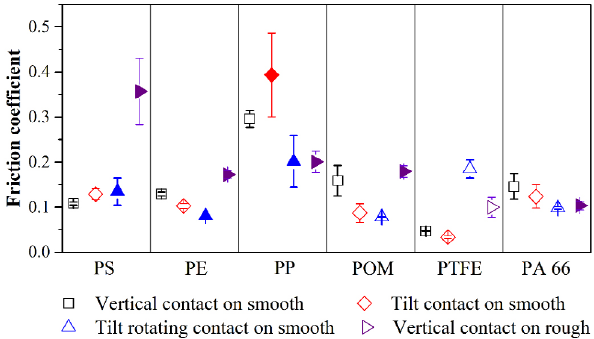
Fig. 15 Friction coefficients of the different polymer spheres with different contact modes (the hollow shape indicates that there is no wear on the silicon surface, while the solid shape indicates that the silicon surface has been